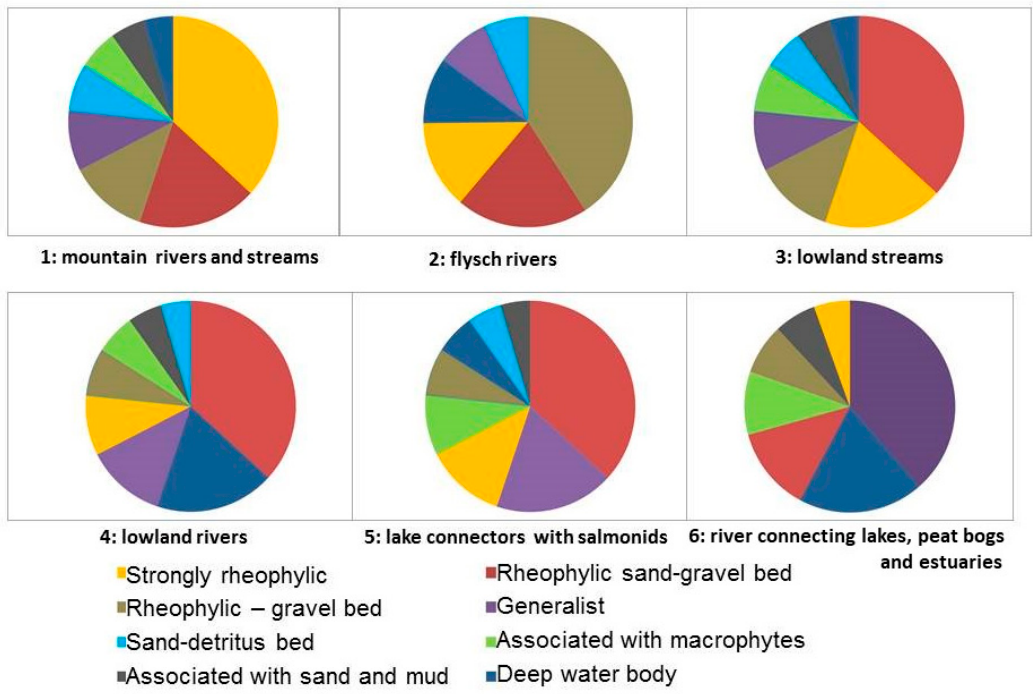
Figure 5. FET-specific expected fish community structures.